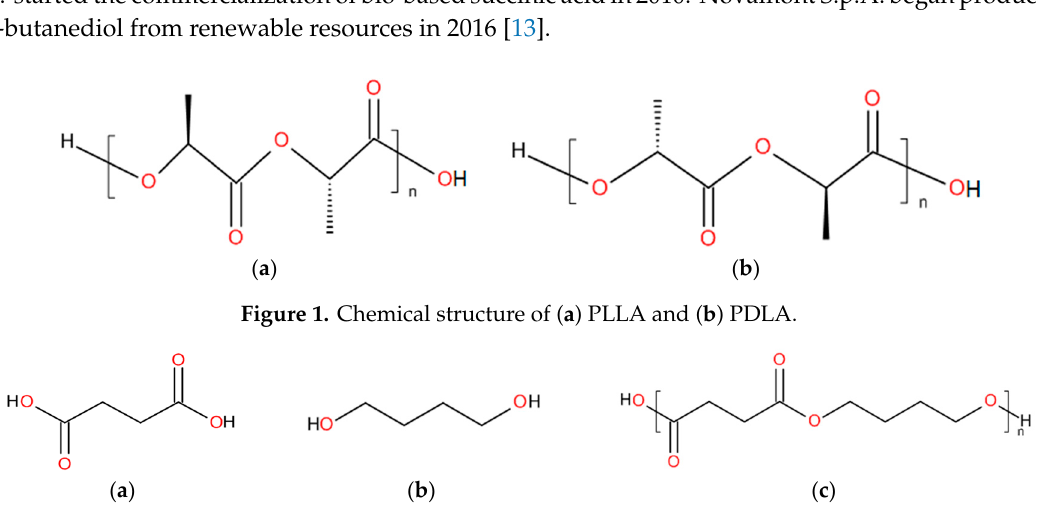
Figure 2. Chemical structure of ( a ) succinate acid, ( b ) 1,4-butanediol, and ( c ) poly(butylene succinate) (PBS).